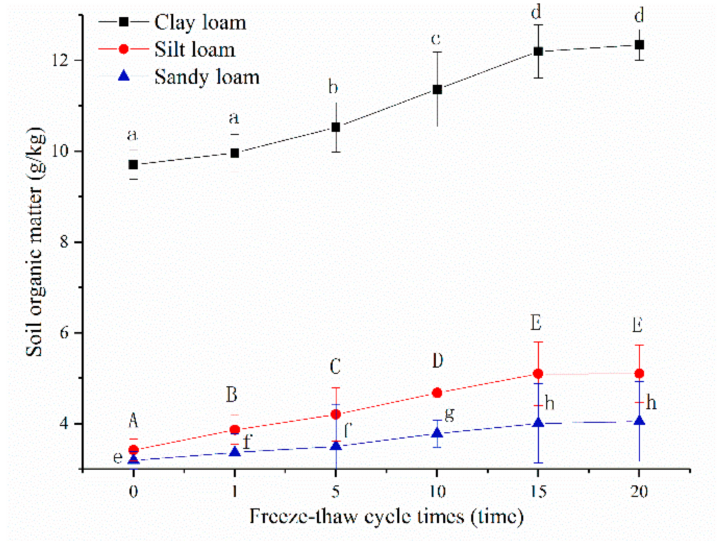
Figure 5. Relationships between soil organic matters and freeze-thaw cycles of three soils. Note: The letters indicated whether the differences in the test results were significant or not. “a, b, c, d” stands for clay loam, “A, B, C, D, E” stands for silt loam, “e, f, g, h” stands for sandy loam. Different letters indicate a significant difference of test results among the different freeze-thaw cycles and soils at the 0.05 level.